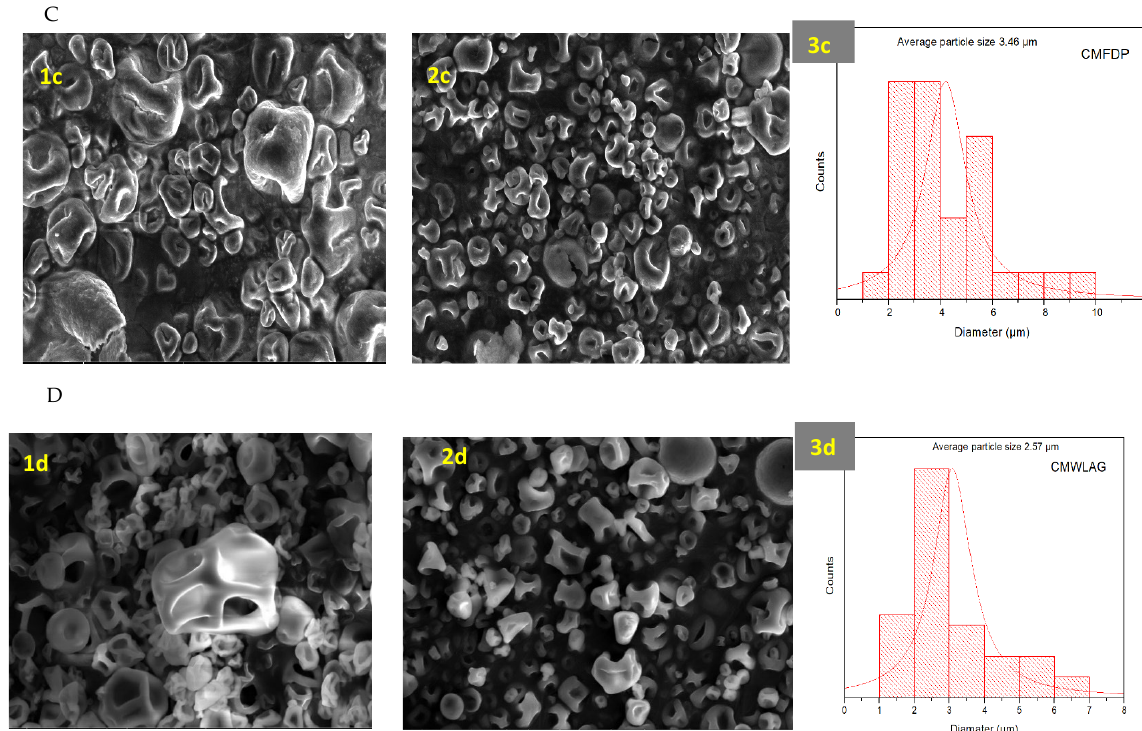
Figure 3. Scanning electron micrographs of freshly produced powders of CM controlled ( A ), CMAQP ( B ), CMFDP ( C ), and CMWLAG ( D ). Photographs ( 1a – 1d ) were taken originally using a magnification of 10,000×, and the scale bar 10 µm scale, Photographs ( 2a – 2d ) were originally taken using a magnification of 5000× and the scale bar 20 µm, ( 3a – 3d represent particle size distribution of CM control, CMAQP, CMFDP and CMWLAG, respectively).